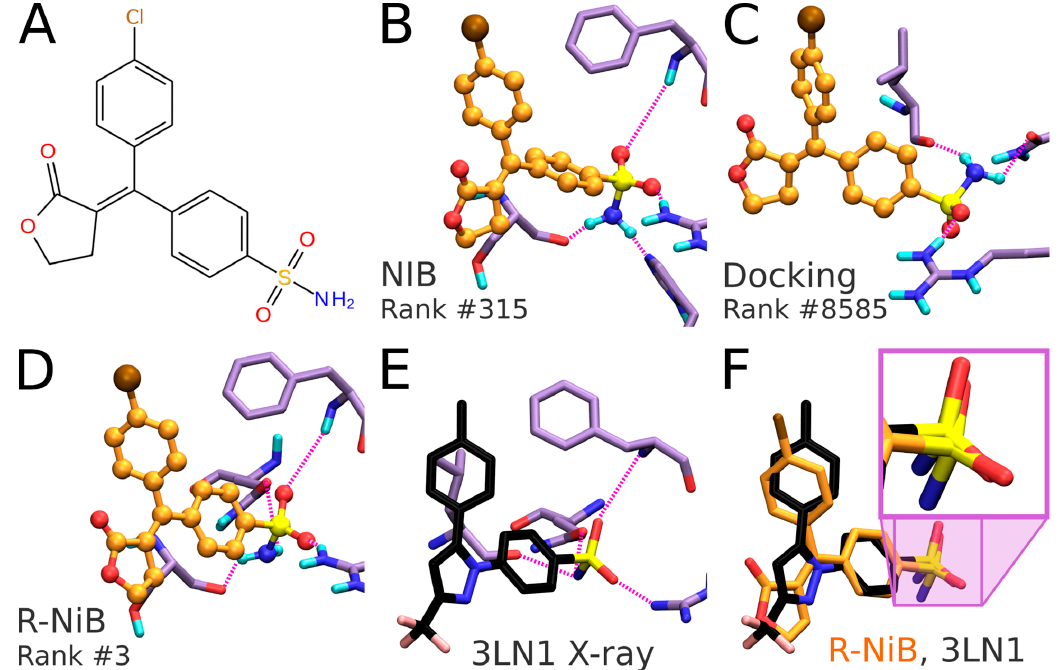
Figure 6. The predicted binding poses and ranking of a known inhibitor for comparison. ( A ) The 2D structure of an established cyclooxygenase-2 (COX-2) inhibitor ZINC03959950 included as an active ligand in the DUD test set [18]. ( B ) The negative image-based (NIB; Figure 1) [1] screening puts forth roughly similar pose for the inhibitor (yellow ball-and-stick model) as ( C ) the flexible docking with PLANTS [17] and ( D ) the negative image-based rescoring (R-NiB; Figure 2) [16]. However, the ranking of the inhibitor differs a lot between these approaches. In the top-ranked poses ( B – D ), the inhibitor’s sulfonamide group H-bonds (pink dotted lines) with the corresponding protein residues (purple stick models; protonated A chain of PDB-entry 1CX2 [20]) differently. ( E ) Notably, the verified binding mode of the inhibitor celecoxib (black stick model; PDB: 3LN1 [2]) indicates how the sulfonamide should be placed inside the cavity. ( F ) In fact, the comparison of celecoxib and the docked inhibitor (yellow stick model) binding modes shows that the sulfonamide placement (zoomed into in the magenta box) by the R-NiB is a match. The NIB selects highly similar alignment for the group as the R-NiB ( B versus C ) and the poorest choice is made by the default docking scoring of PLANTS ( E versus C ). The top-ranked inhibitor binding modes for both the NIB screening (conformers from the RDKit routine; Table 1) and rescoring were acquired using Model III (Figure 4H; PDB: 3LN1; Table 3).